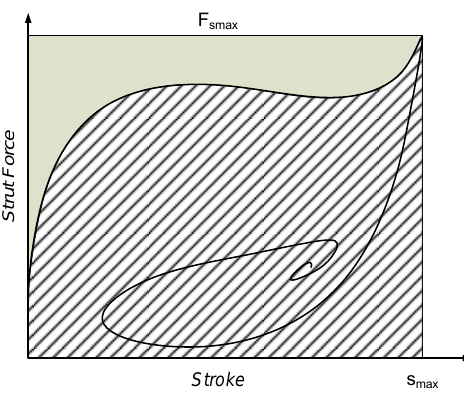
Figure 3. Strut force–stroke diagram.